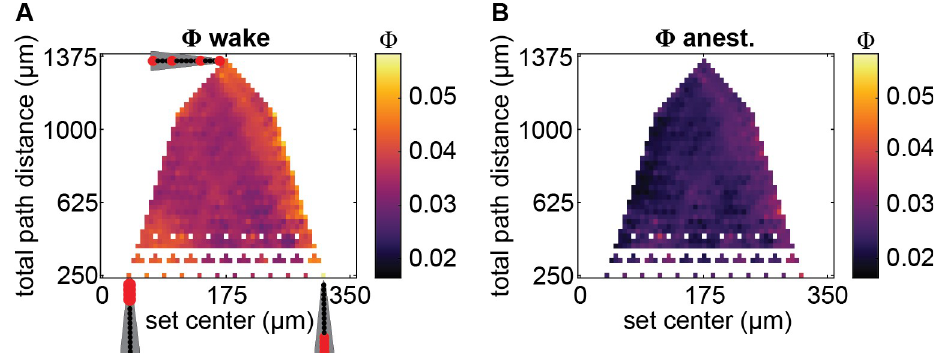
Fig 3. Spatial map of system-level integrated information F . ( A ) System-level integrated information F values during wakefulness, averaged across flies, as a function of average channel location relative to the position of the most central channel (x-axis; larger values indicate channel sets which on average are more peripherally located), and sum of pairwise distances between each pair of channels (total path distance; y-axis) within each channel set. Channel arrays, as in Fig 1A, indicate example locations of channels (in red) and their spacing along the two axes. Channel sets with identical centers and path distances were averaged. A subset of otherwise unfilled values in the map were linearly interpolated to reduce gaps in the map. ( B ) System-level integrated information F values during anesthesia.